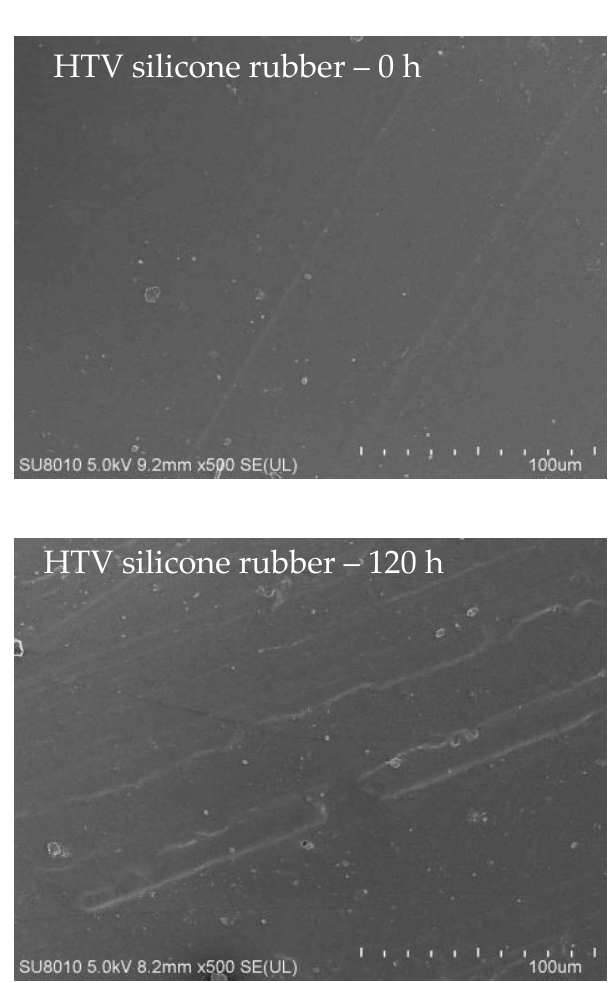
Figure 3. The appearance changes of two samples after different aging times: ( a ) The average gray level of the alicyclic epoxy resin sample; ( b ) the average gray level of the HTVSR sample.